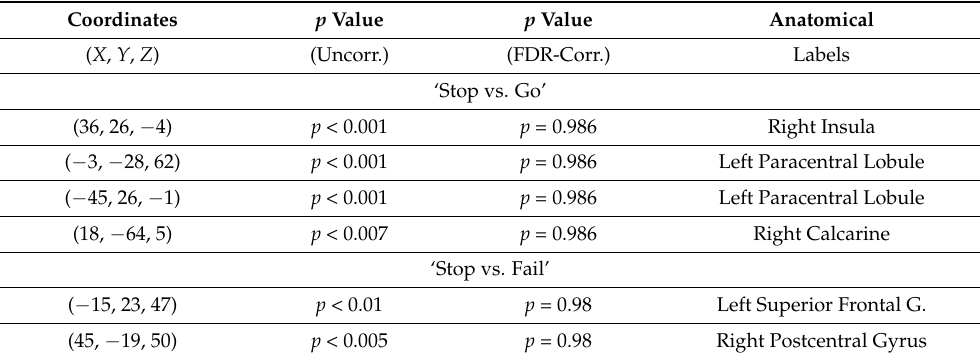
Table 3. Summary of coordinates and analysis results corresponding to the significant clusters of activation for Stop-signal